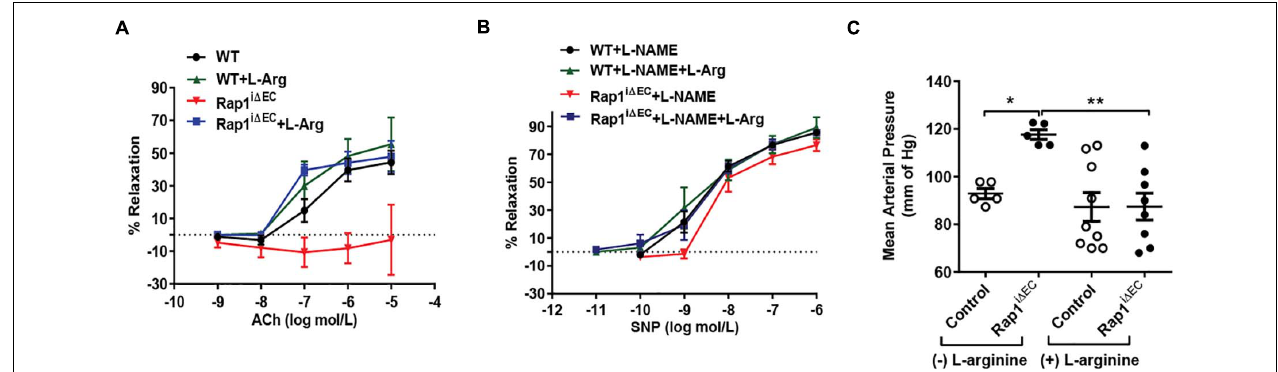
FIGURE 1 | Endothelial dysfunction in Rap1i (cid:49) EC mice is attenuated by L-arginine (L-Arg) supplementation. (A,B) Corrected vasorelaxation. Concentration dependent vasorelaxation of U466169-preconstricted aortae from control (WT) and Rap1 i (cid:49) EC mice treated with or without L-arginine in response to ACh (A) , sodium nitroprusside (SNP) (B) . SNP response was measured in presence of L-NAME, an NO blocker. Values are means ± SEM ( n = 6). (C) L-arginine treatment normalizes blood pressure in Rap1 i (cid:49) EC mice. Systolic blood pressure was measured in control (WT) and Rap1 i (cid:49) EC mice with or without L-arginine supplementation in drinking water. Values are means + SEM ( n = 5–9).* indicates p < 0.05 vs. control without L-arginine; ** indicates p < 0.01 vs. Rap1 i (cid:49) EC without L-arginine. One-way ANOVA Tukey’s multiple comparison test was applied to compare statistical